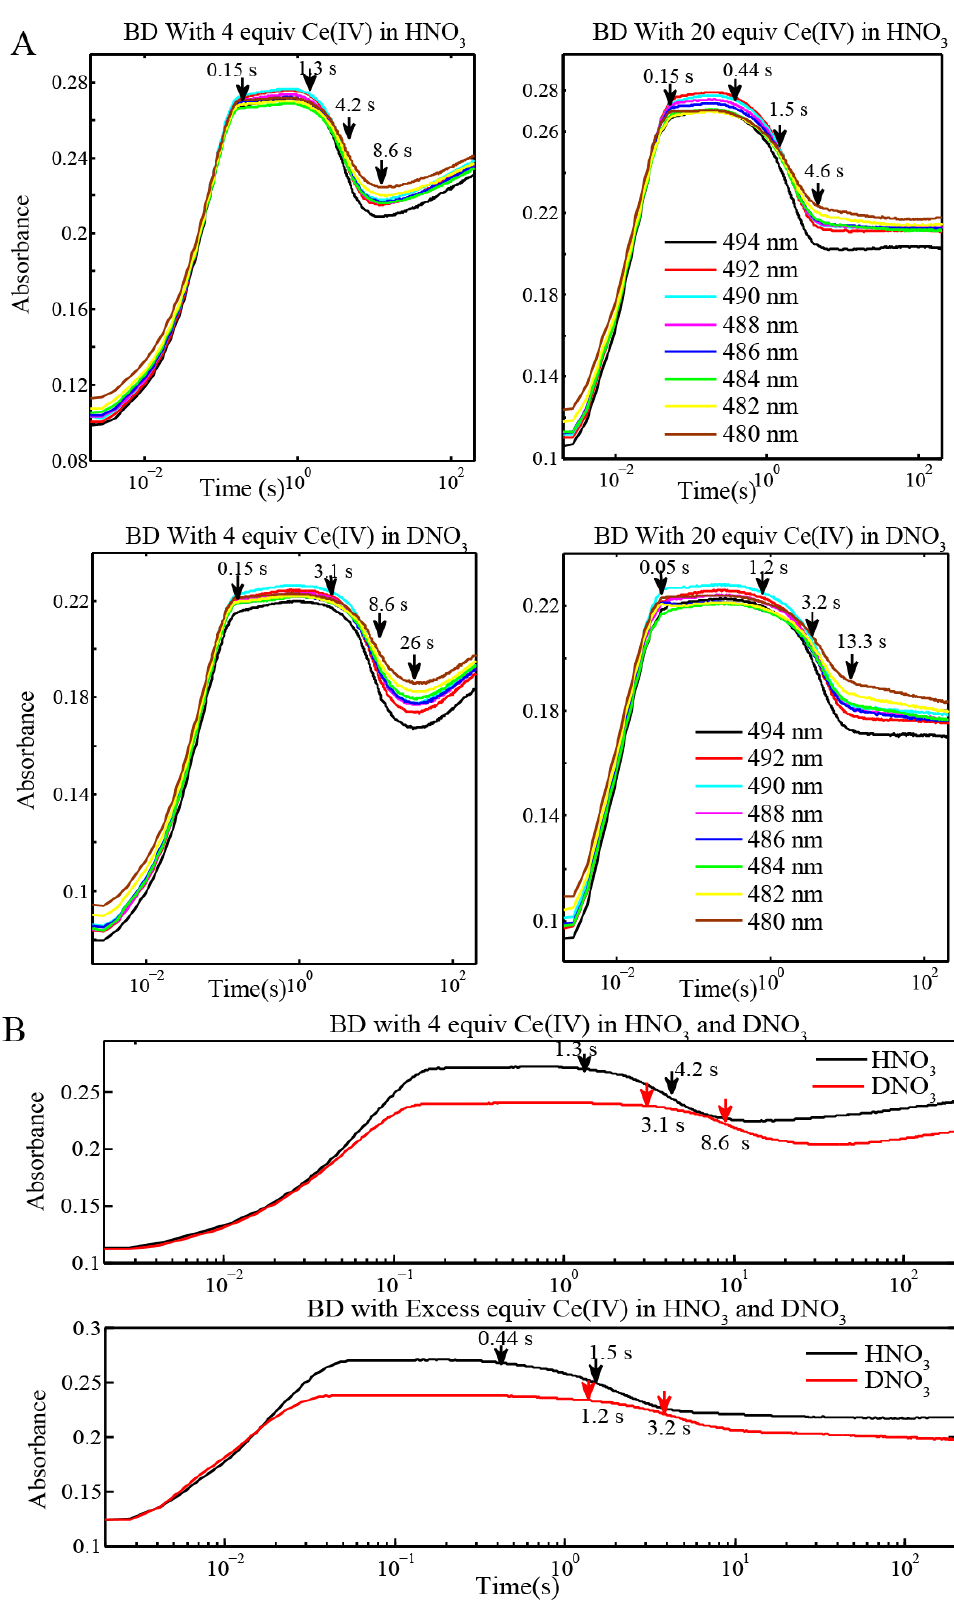
Figure 3. ( A ) Stopped-flow UV-Vis measurement of BD[3,3] (0.1 mM) oxidation with 4 equiv and 20 equiv of Ce(IV) at pH 1 (HNO absorbance traces at 480 nm in H Ce(IV) at pH